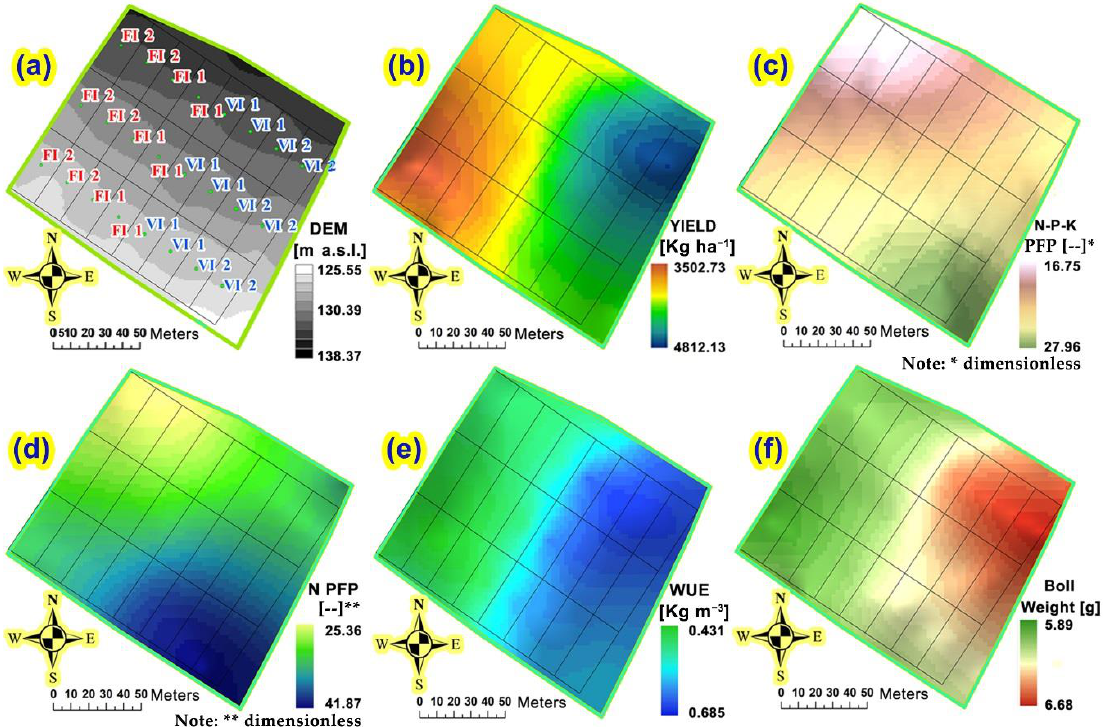
Figure 7. The modeling results and spatial variability GIS field maps of: ( a ) the field’s digital elevation model (DEM), ( b ) the cotton yield [Kg ha −1 ], ( c ) the N-P-K fertilizer PF productivity, ( d ) the nitrogen PF productivity, ( e ) the WUE [Kg m −3 ], and ( f ) the cotton boll weight [g].